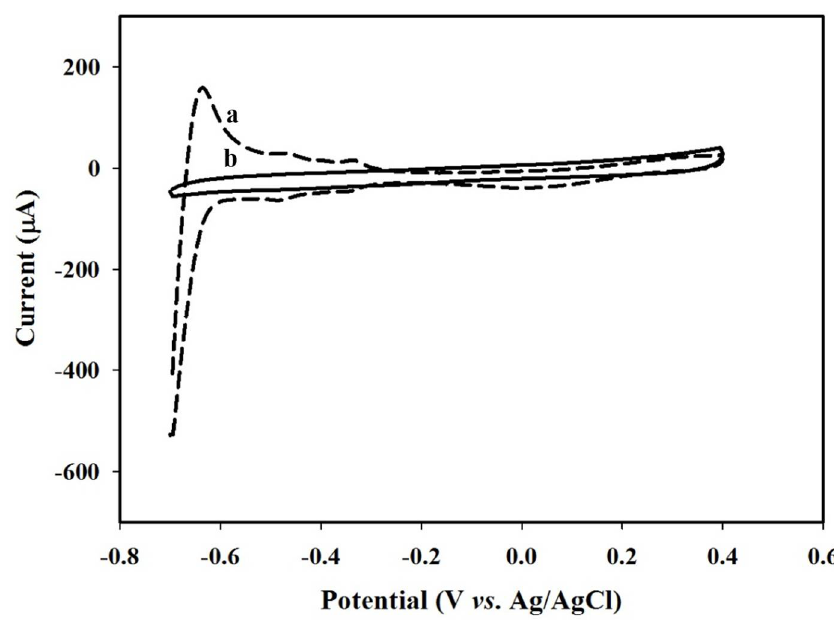
Figure 1. The profiles of cyclic voltammetry (CV) for (a) bare Pt, (b) modified PEDOT:BSA/Pt electrodes in 0.1 M PBS buffer with pH = 6.2 and a scan rate of 0.2 V/s.